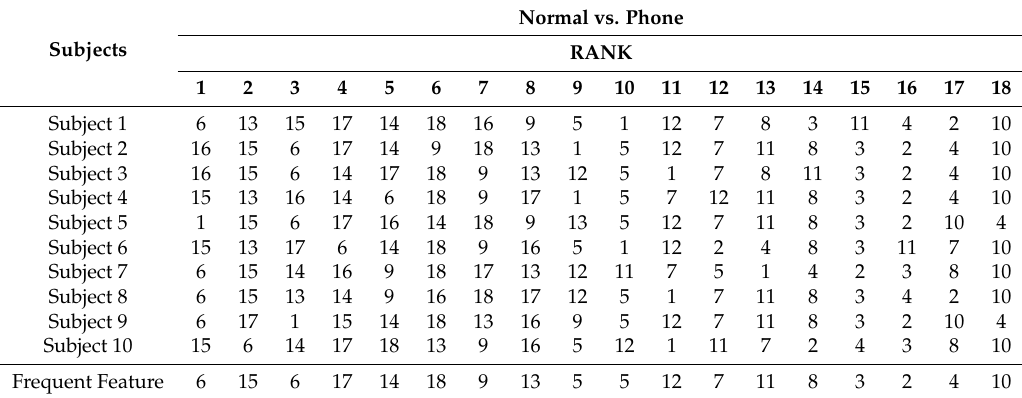
Table 4. Support vector machine-recursive feature elimination (SVM-RFE) feature ranking for normal vs. phone.